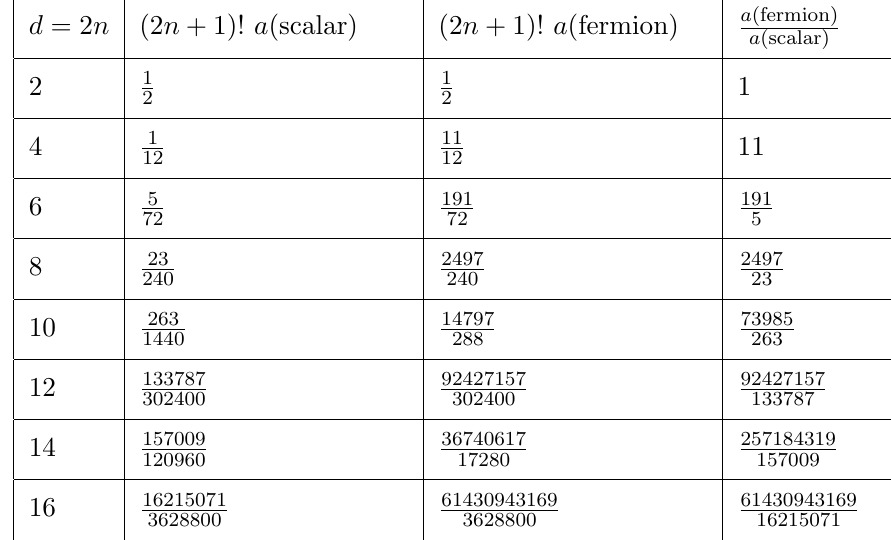
Table 2 . The a coe(cid:14)cients of the type-A trace anomaly of a real conformal scalar and Dirac fermion. We have multiplied them by (2 n + 1)! to make the numbers more readable.